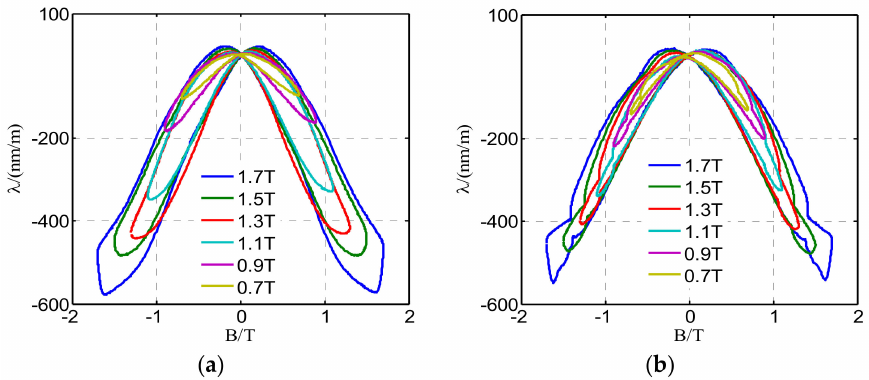
Figure 6. Measured butterfly curves under di ff erent harmonic magnetizations when the peak value of flux density B m varies from 0.7 T to 1.7 T: ( a ) Harmonic excitation, in which the third harmonic B 3 accounts for 50% of the fundamental component B 1 ; ( b ) harmonic excitation, in which the ninth harmonic B 9 account for 50% of the fundamental component B 1